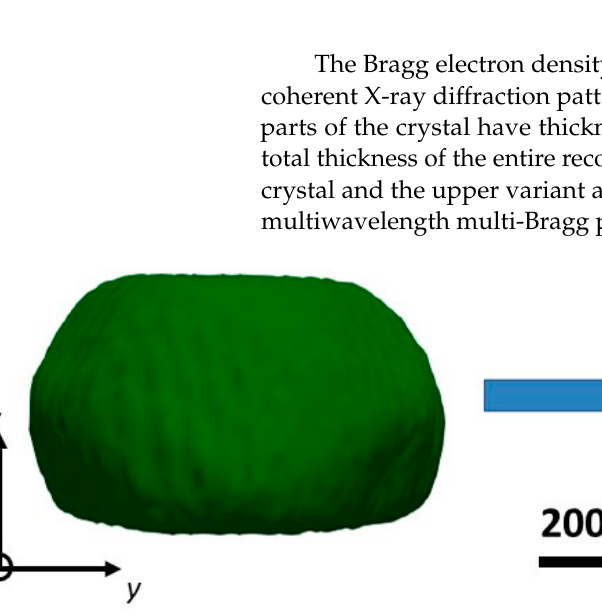
Figure 6. Bragg electron density of the twinned Au crystal reconstructed from the 3D Bragg coherent X-ray diffraction patterns shown in Figure 5. The left-hand side shows the reconstruction of the entire crystal reconstructed from the Au 111 Bragg reflection, while the right-hand side shows the two variants reconstructed from the Au 200 and Au 002 Bragg reflections.